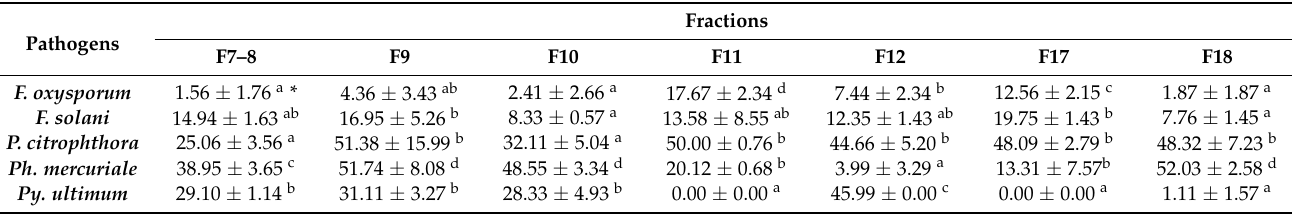
Table 7. Mycelial growth inhibition percent of pathogens tested in the presence of purified Raphanus raphanistrum dichloromethane extract fractions.